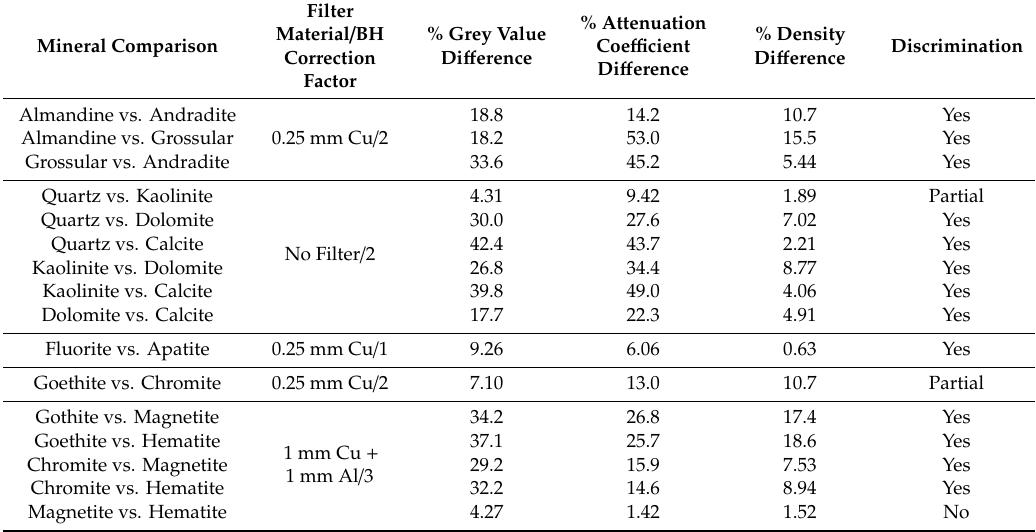
Table 4. Mineral discrimination using linear attenuation coe ffi cient di ff erence at 45.5 keV e ff ective energy in conjunction with grey value and density di ff erence. BH = beam